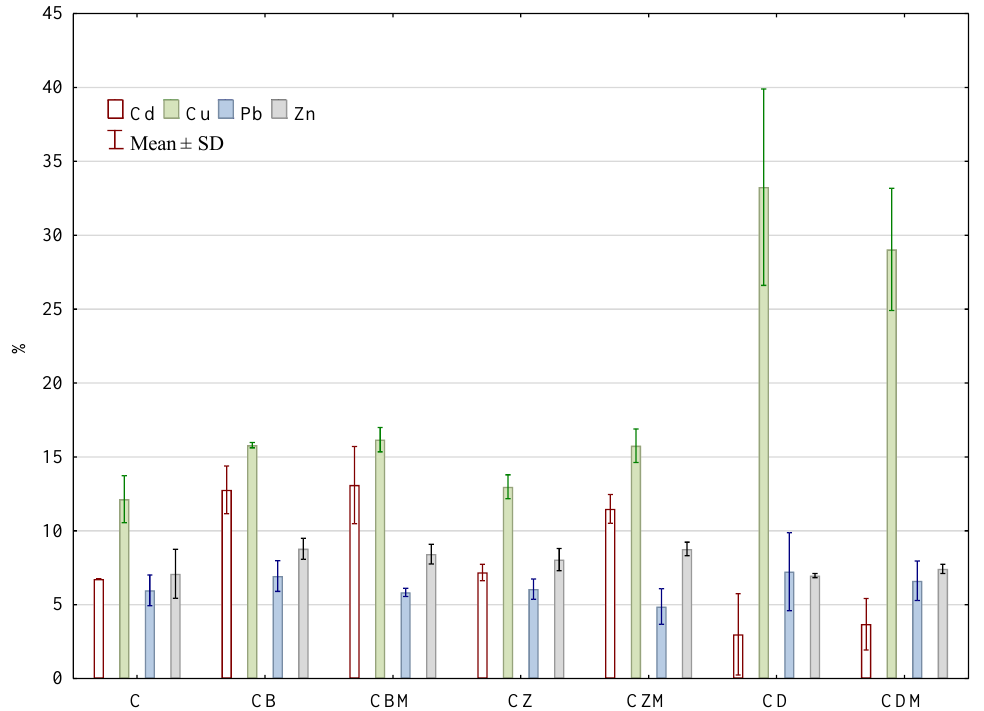
Figure 2. Share of water-extracted heavy metals in the total heavy metal content in composts. C— biomass without the addition of functionalized materials and bacterial metabolites, CB—biomass with the addition of biochar, CBM—biomass with the addition of biochar and bacterial metabolites, CZ—biomass with the addition of zeolite, CZM—biomass with the addition of zeolite and bacterial metabolites, CD—biomass with the addition of diatomite, CDM—biomass with the addition of diatomite and bacterial